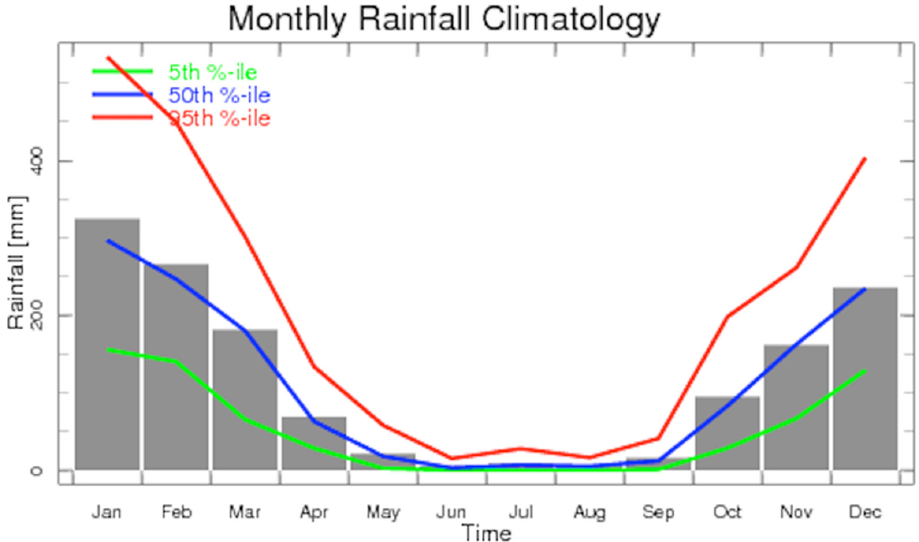
Figure 5. Rainfall climatology (normal) during the month of July over Ethiopia.